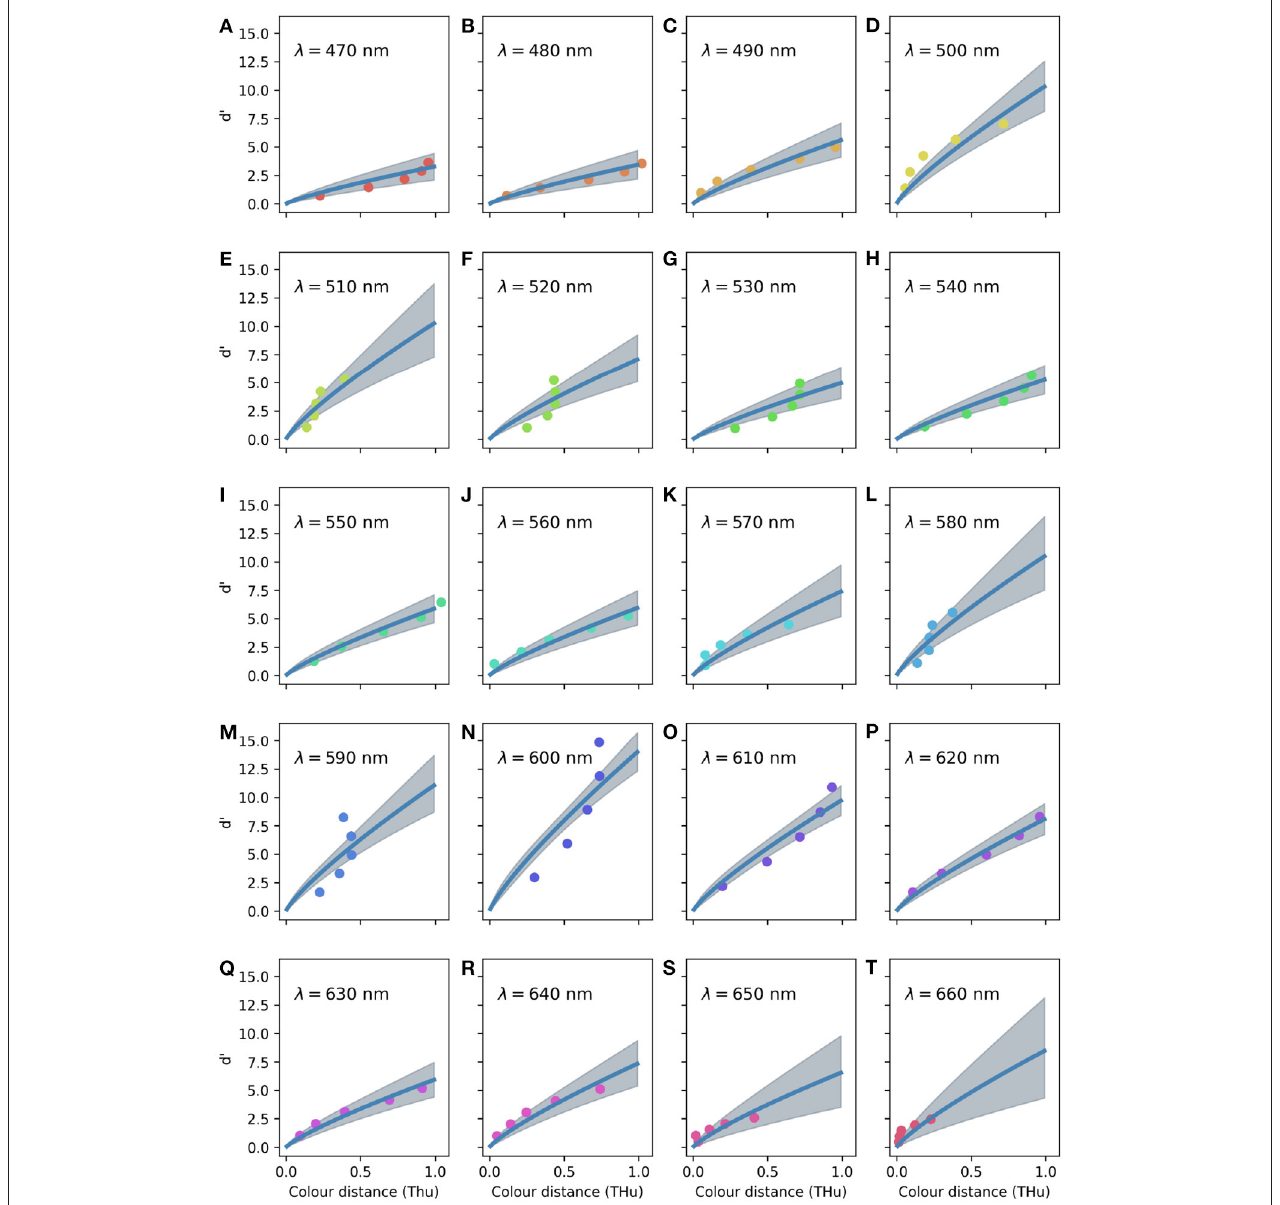
FIGURE 5 | Colour discrimination sensitivity model for a violet sensitive bird accounting for fixed and random terms for of the 20 reference wavelengths tested by Wright (1972) as indicated on the legend for (A–T) . Circles indicate observations corresponding to the five different stimuli tested for each reference wavelength. Marker colours have no relationship with the visual appearance of the stimuli, hues were selected to ease visual